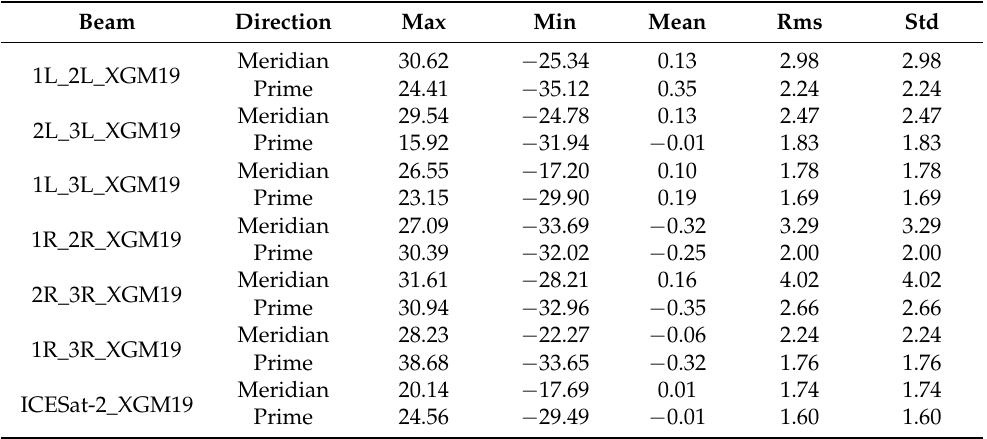
Table 13. Statistics of differences between gridded DOVs calculated by the cross-beam DOVs and the XGM2019e_2159-DOV model (Unit: arc_sec).